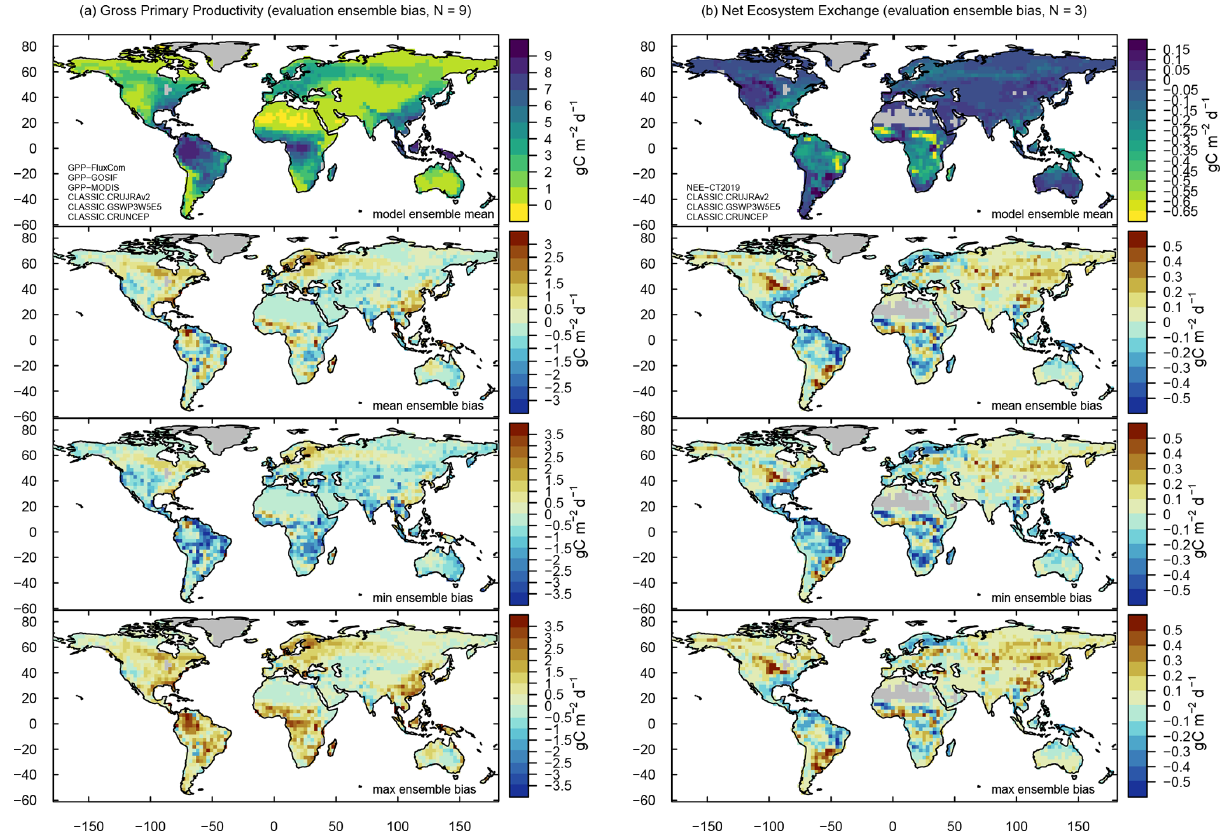
Figure A16. Same as Fig. 7 but for (a) gross primary productivity and (b) net ecosystem exchange.